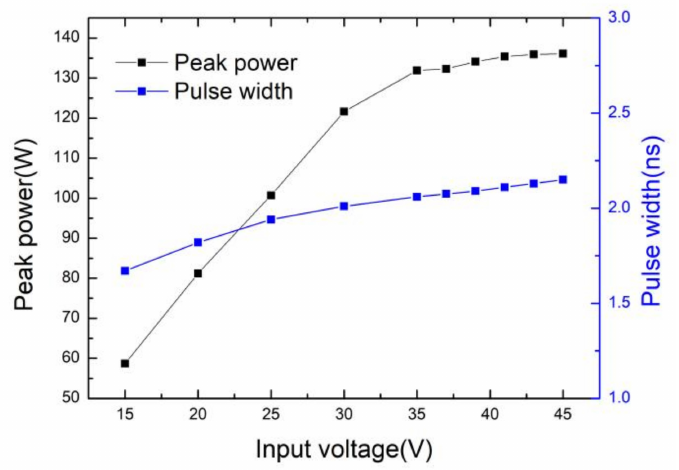
Figure 13. Variation of laser pulse peak power and pulse width at different input